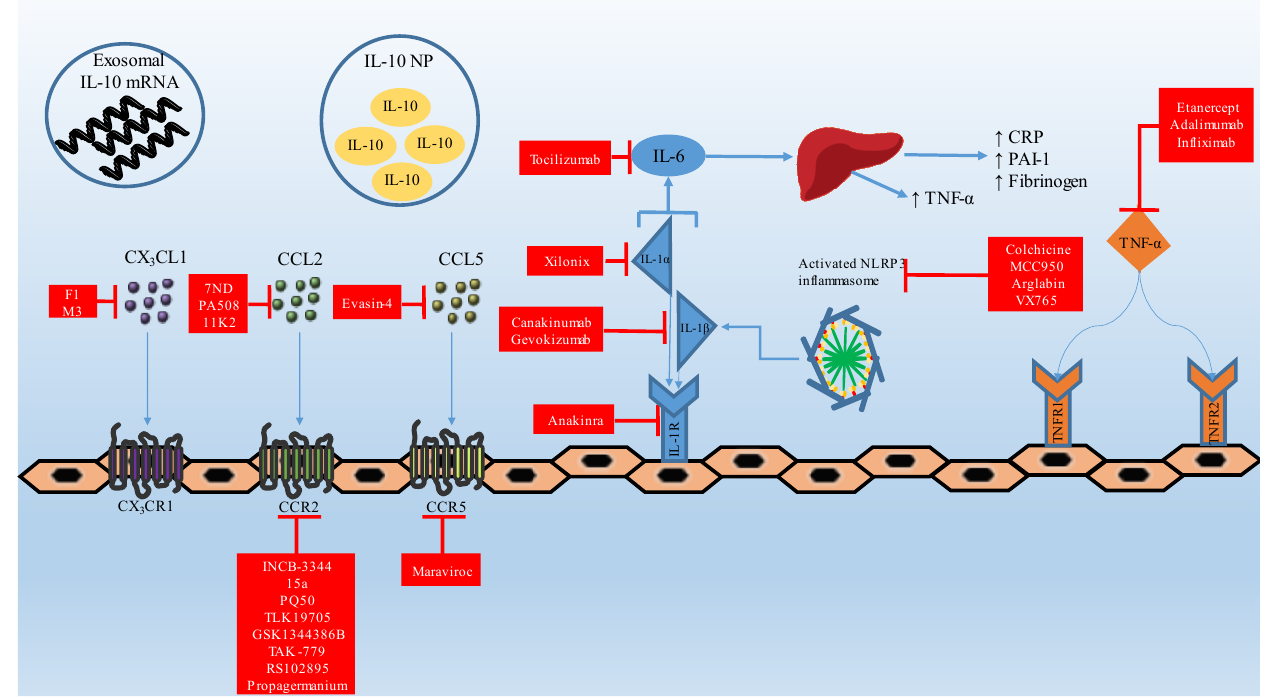
Figure 2. Cytokine-based therapeutics in coronary atherosclerotic disease. IL: interleukin; NP: nanoparticle; IL-1R: interleukin-1 receptor; TNF- α: tumor necrosis factor - α ; CRP: C reactive protein; PAI-1: plasminogen activator inhibitor-1; TNFR: tumor necrosis factor receptor.